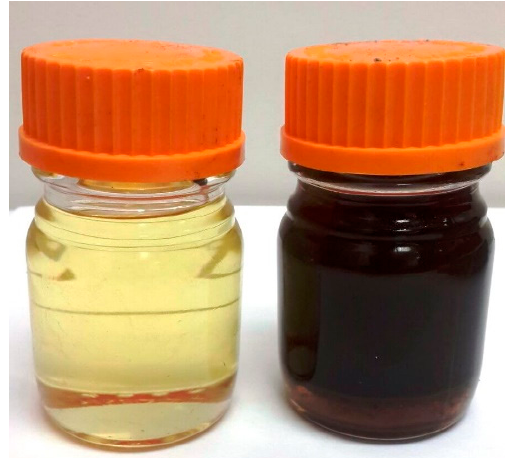
Figure 8. Canola oil (used in oil bubbler for treatment III) before and after the test.